Question: Give a one-sentence summary of this figure.
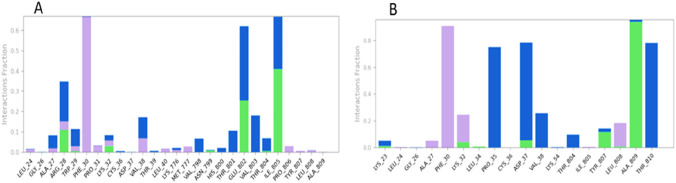
Answer: Interaction frequency histograms depicting hydrogen bonds, hydrophobic contacts, water bridges, and ionic interactions between TLR7 residues and (A) bavachinin and (B) oroxylin A over 100-ns molecular dynamics simulations.